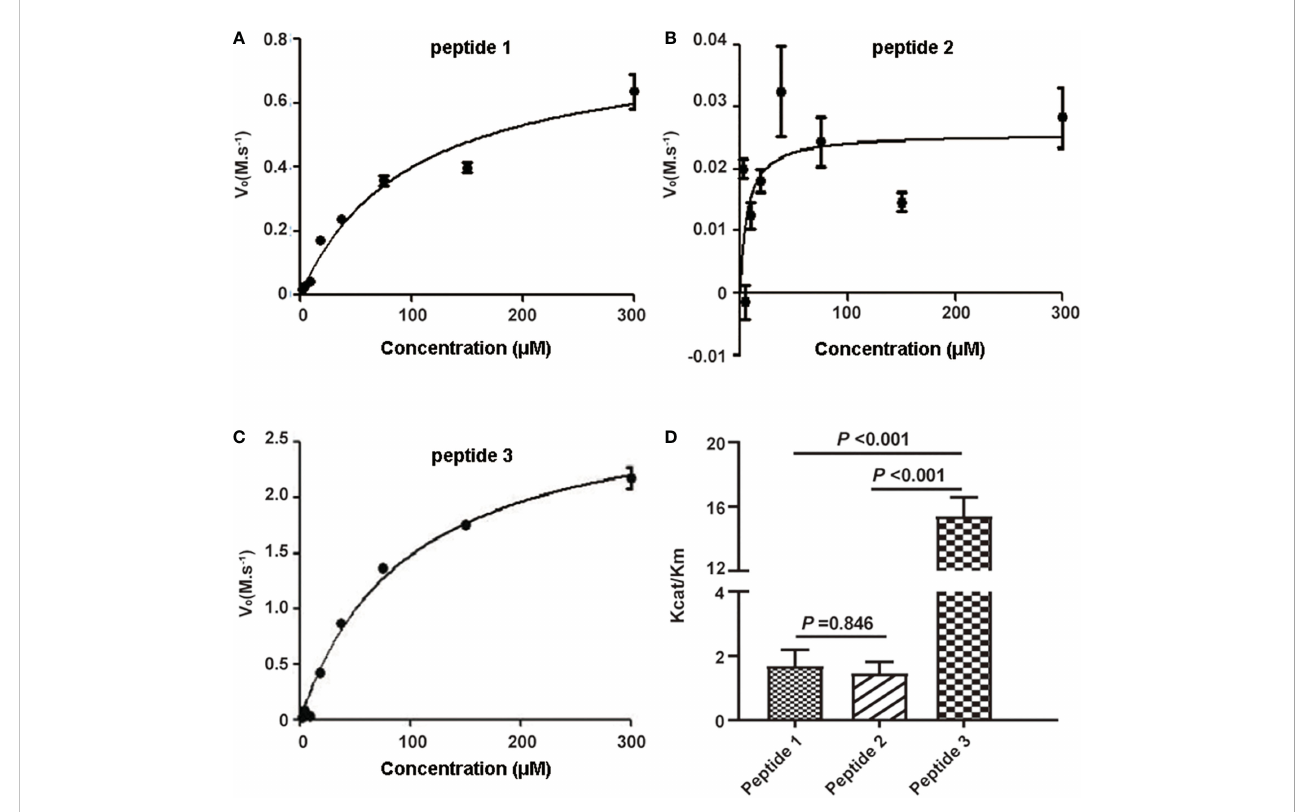
FIGURE 2 Kinetic analysis of human active C1s on cleavage of synthetic peptide substrates. Michaelis-Menten curves were generated where velocity ( v o ) was plotted against the concentrations of (A) peptide 1, (B) peptide 2, and (C) peptide 3; (D) K cat /K m values of the proteolytic activity of C1s on three peptide substrates. Data are presented as the means ± standard deviation (n = 3). P -values were calculated by one-way